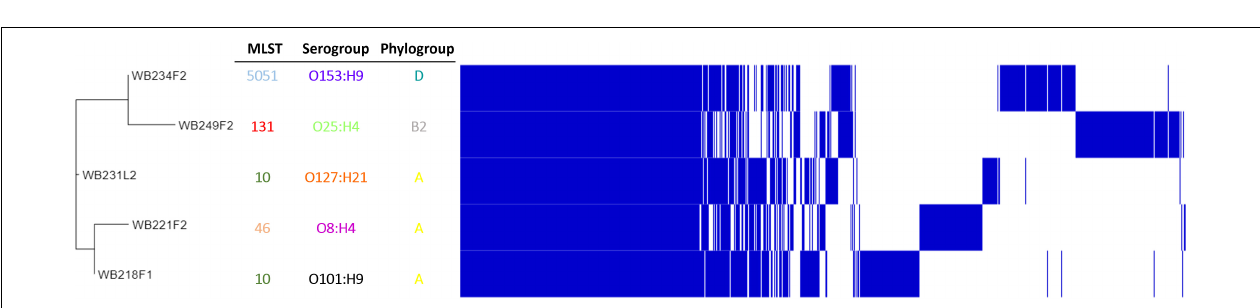
FIGURE 2 | Genomic context of ES β L genes in wild boar isolates. Each line represents a contig harbouring the ES β L determinants, and it is identified by the name of strain and number of the contig. bla CTX , bla OXA , bla TEM , and bla SHV genes are coloured in purple, while the mobile elements are evidenced in blue. Green, yellow, orange, and light blue indicate other AMR genes, while hypothetical or other proteins are white.